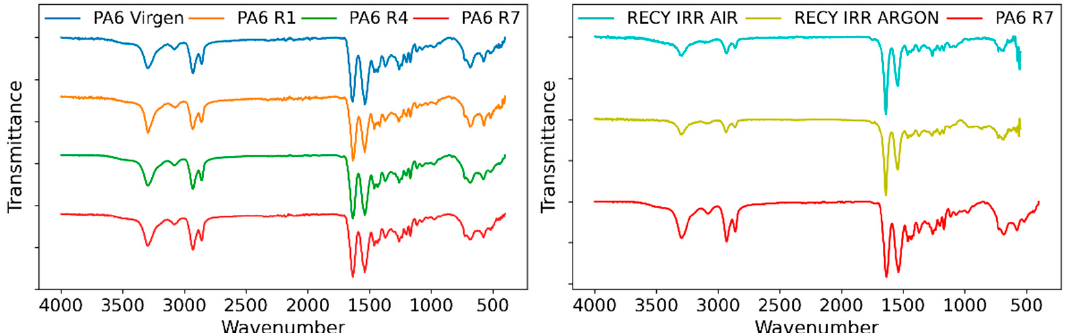
Figure 8. FTIR spectra. Left: virgin sample and samples extruded 1 (R1), 4 (R4) and 7 (R7) times. Right: recycled samples without irradiation and irradiated at 100 kGy in both air and argon.